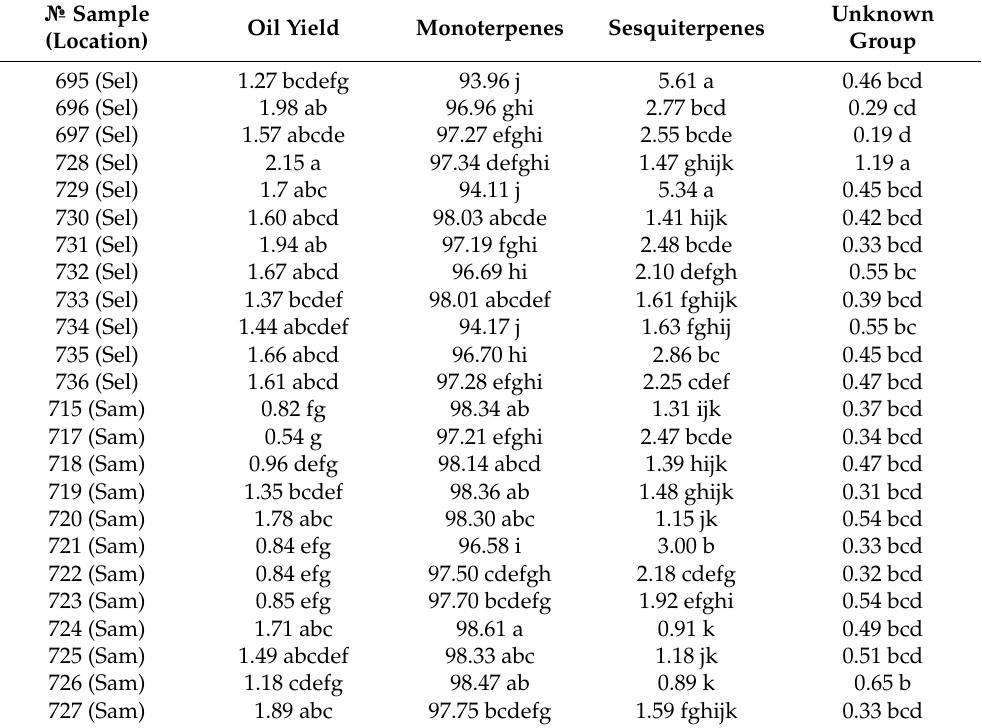
Table 2. Mean (%) oil yield of Bulgarian S. pilosa monoterpenes, sesquiterpenes, and an unknown group obtained from 24 samples collected at the populations of the Balkan Mountains (Selce) and the East Rhodope Mountains (Samokitka).